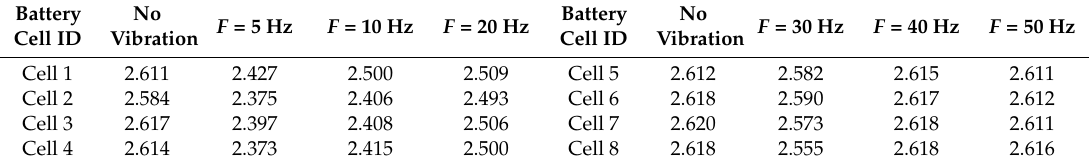
Table 4. The discharge capacity samples under different vibration frequency conditions.